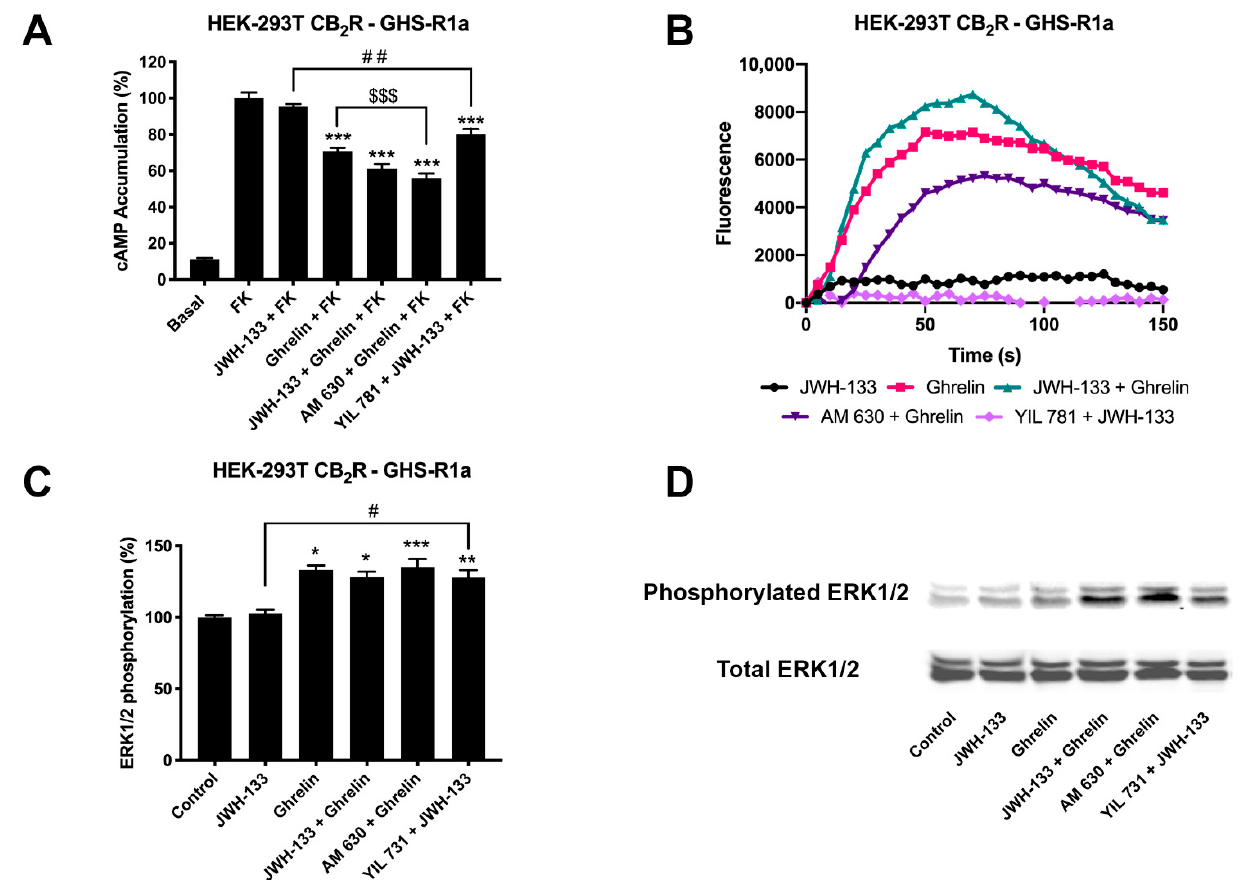
Figure 3. CB 2 -GHSR1aHet-mediated signaling in transfected HEK-293T cells. Panels ( A – C ) HEK-293T cells were transfected with cDNAs encoding for GHSR1a (1.5 µg) and CB 2 R (1 µg) ( A,C ) or with GHSR1a (1.5 µg), CB 2 R (1 µg) and the GCaMP6 calcium sensor ( B ) and pre-treated with antagonists, 1 µM YIL 781 -for GHSR1a- and 1 µM AM 630 -for CB 2 R, and subsequently stimulated with selective agonists, 200 nM ghrelin -for GHSR1a- and 200 nM JWH-133 -for CB 2 R, individually or in combination. cAMP levels were analyzed by the Lance Ultra cAMP kit and results were expressed in % respect to levels obtained upon 0.5 µM forskolin stimulation ( A ). Representative traces of intracellular Ca 2+ responses over time are shown (9 independent experiments) ( B ). ERK 1/2 phosphorylation was determined by immunoblot using the Odyssey infrared scanner (LI-COR Biosciences) ( C,D ). In cAMP accumulation and MAPK pathway signaling-related assays, the values are the mean ± SEM of 8 different experiments performed in triplicates. One-way ANOVA followed by Dunnett’s multiple comparison post-hoc test were used for statistical analysis..* p < 0.05, ** p < 0.01, versus basal in pERK1/2 assays; *** p < 0.001; versus forskolin treatment in cAMP or versus basal in pERK1/2 assays, # p < 0.05 versus JWH-133 treatment in pERK assays, ## p < 0.01 versus JWH-133+FK treatment in cAMP assays; $$$ p < 0.001; versus ghrelin+FK treatment.